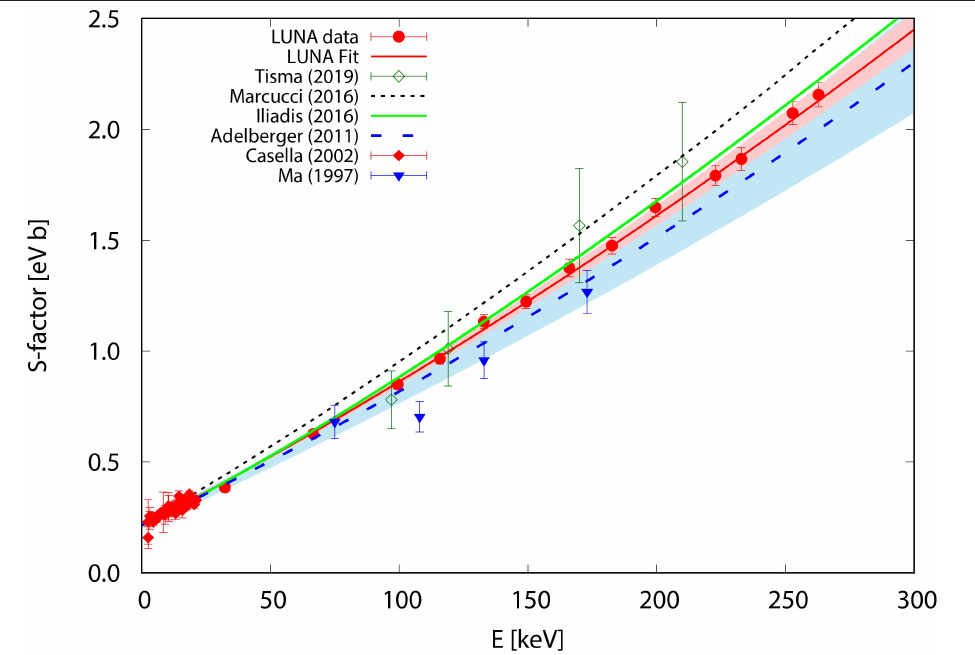
Figure 1. S-factor of the D(p, γ ) 3 He reaction; LUNA results are represented with filled red circles. Other experimental data are also shown. The best fit (red solid line) include all the reported experimental data. Band represents the 68% confidence